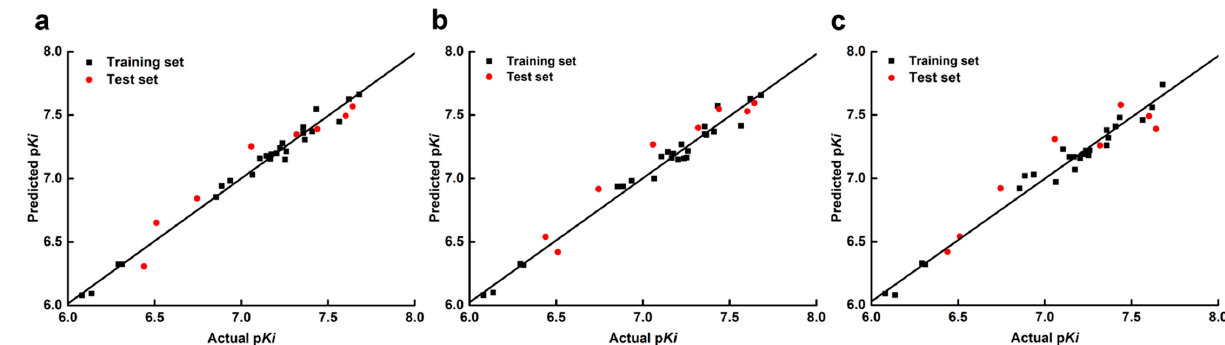
Figure 3. The scatter plots of actual vs. predicted pKi values of all used imidazo[1,2-a]-pyridine derivatives based on the CoMFA ( a ), CoMSIA ( b ), and Topomer CoMFA ( c ) models.